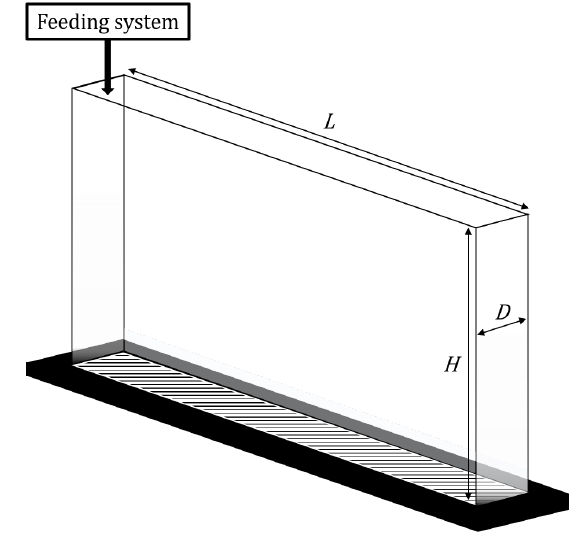
Figure 1. Testing cell representation.